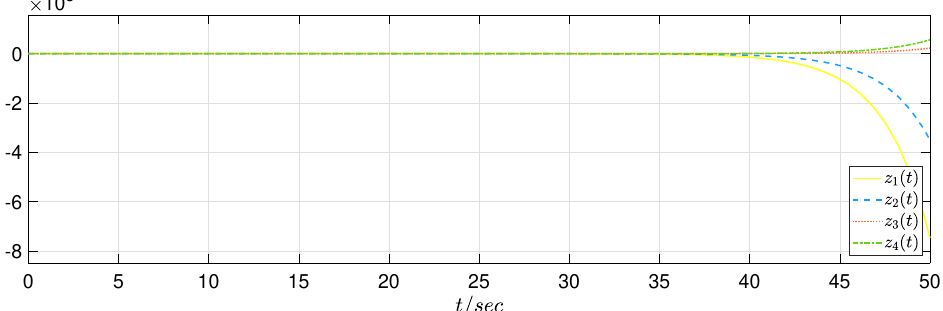
Figure 5. State response of original system without control.